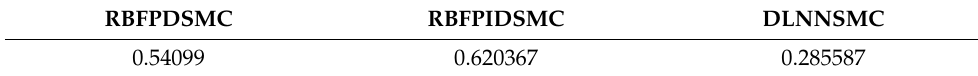
Table 5. Average values of D E .